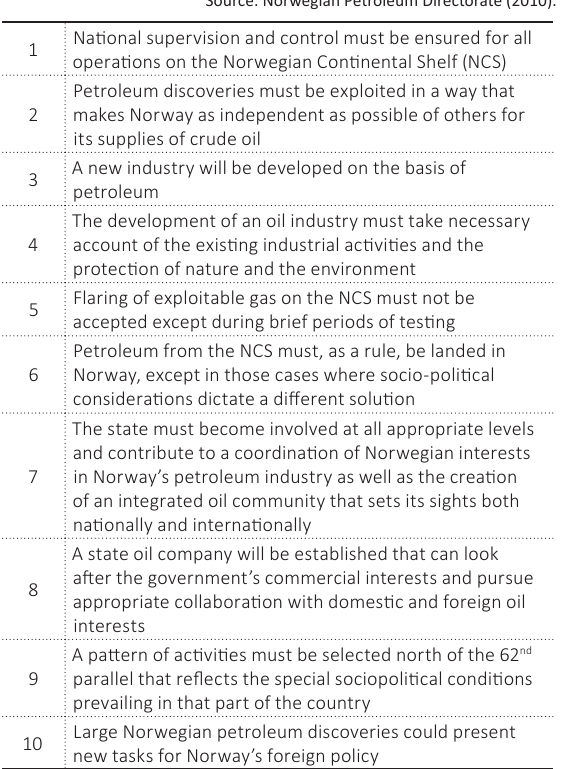
Table 1. The ten oil commandments to ensure efficient utilization of resource rent from Norwegian petroleum